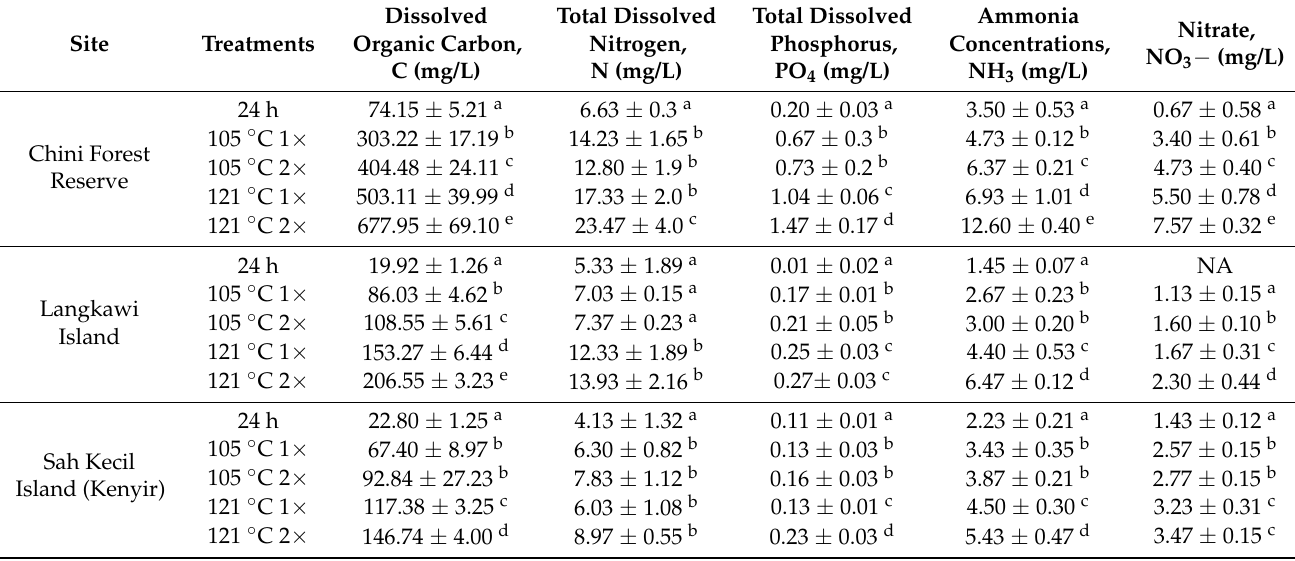
Table 3. Selected chemical analysis of soil extracts using various extraction